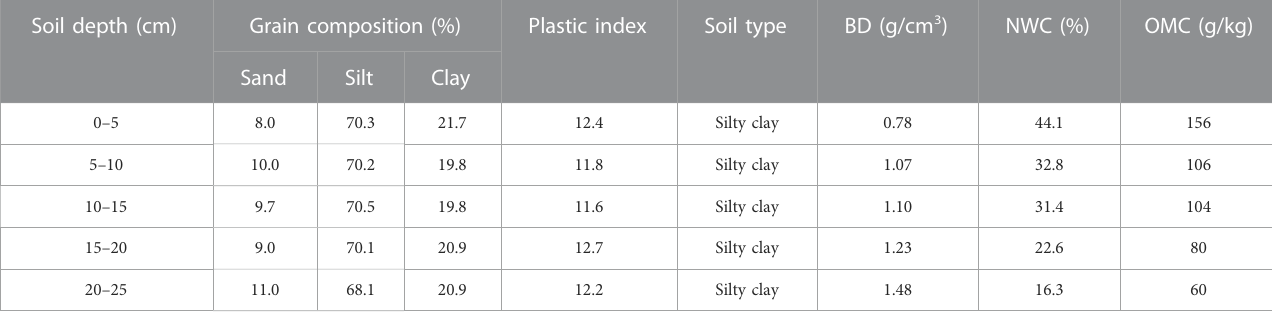
TABLE 1 Physical properties of alpine meadow soil at different depths.